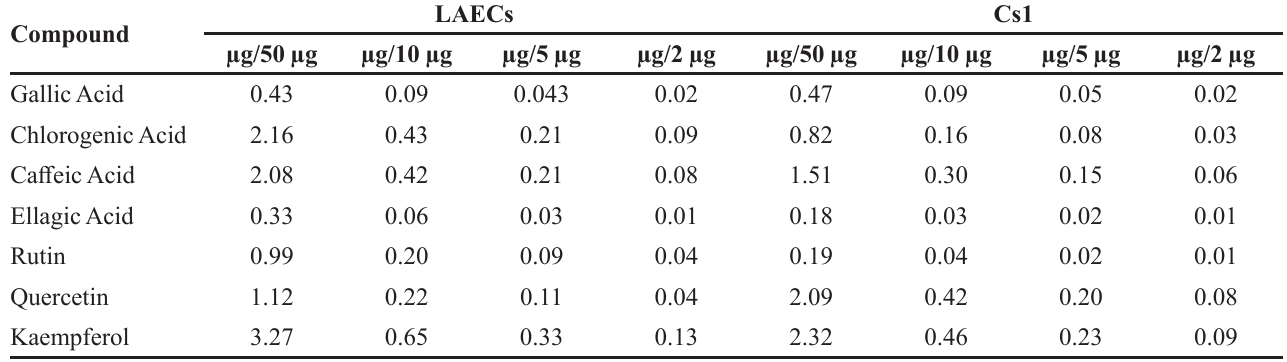
TABLE IV - Composition of lyophilized aqueous extract of C. speciosa (LAECs) and raw ethanol extract (Cs1), at the concentrations used for the in vitro tests